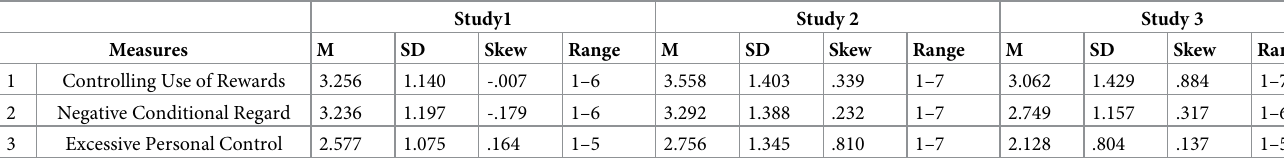
Table 2–1. Population